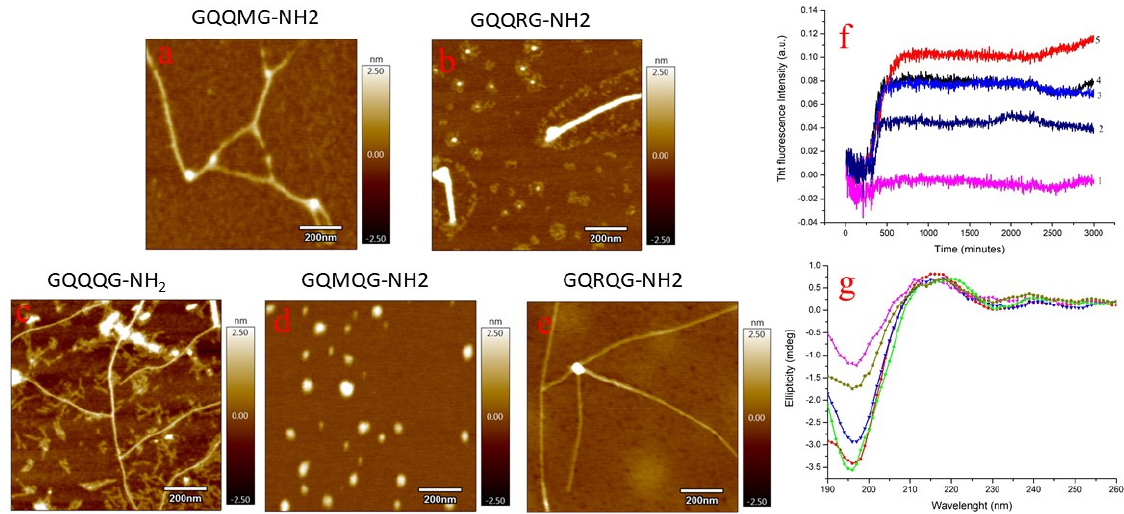
Figure 3. Liquid AFM measurements of GQQMG ( a ), GQQRG ( b ), GQQQG, ( c ) GQMQG ( d ), and GQRQG ( e ) peptides. AFM images were acquired after 500 min of incubation. Panel ( f ): ThT assay of GQMQG (1), GQRQG (2), GQQQG (3), GQQMG (4), and GQQRG (5) peptides. Panel ( g ): CD spectra acquired immediately after solubilization of the pentapeptides in water: GQMQG (green line), GQQMG (red line), GQQRG (blue line), GQRQG (dark yellow line), and GQQQG (magenta line). Peptide concentration was 10 µM, temperature 25 °C, pH = 7.4 and ionic strength 0.1 M in NaCl. In CD measurements, the ionic strength of the solutions was adjusted by NaF. Table 2. Secondary structure assignment of penta-peptides using ATR spectroscopy measurements. Spectra were acquired after 500 min of incubation. Frequency assignment from reference [20].